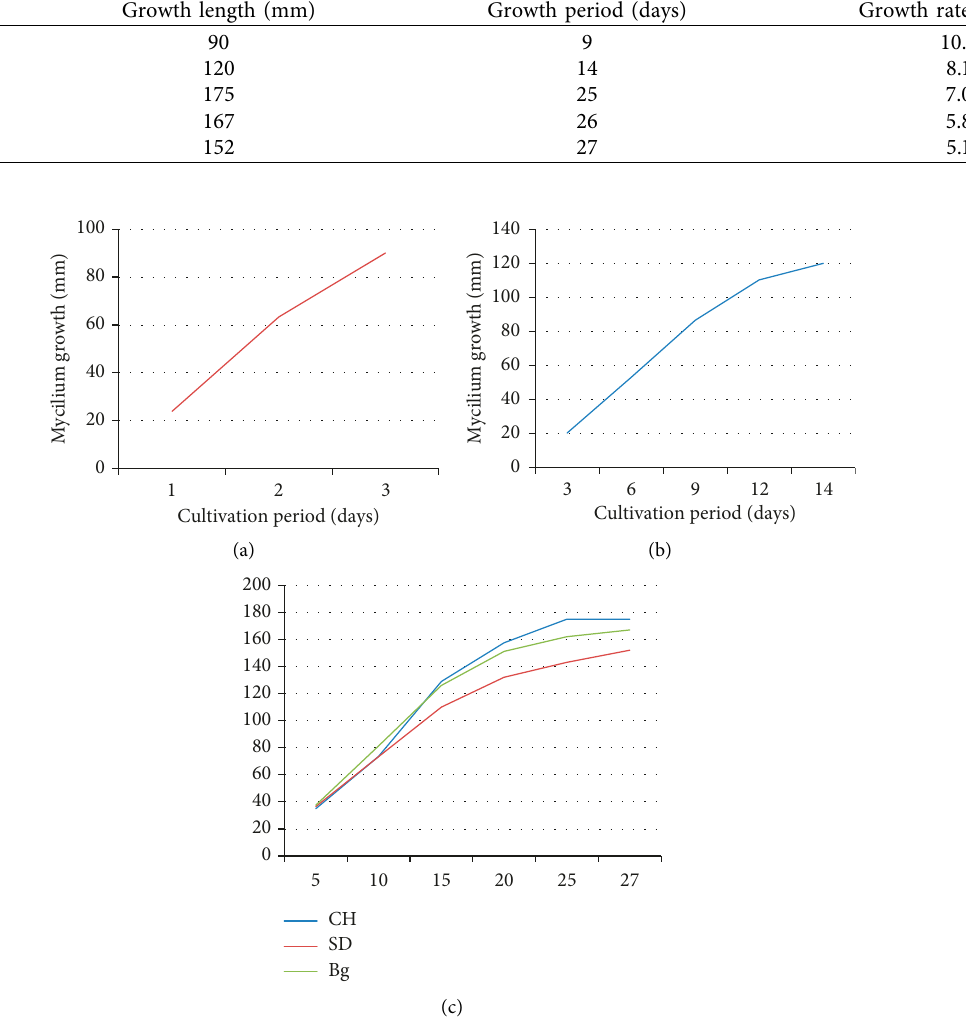
Figure 1: Mycelium growth rate grown on (a) PDA, (b) grain (spawn), and (c) different substrates: CH (coffee husk), SD (sawdust), and Bg (bagasse). Table 2: Mean and standard deviation of mycelium growth rate at different growth media. Mean growth rate (mm/day)